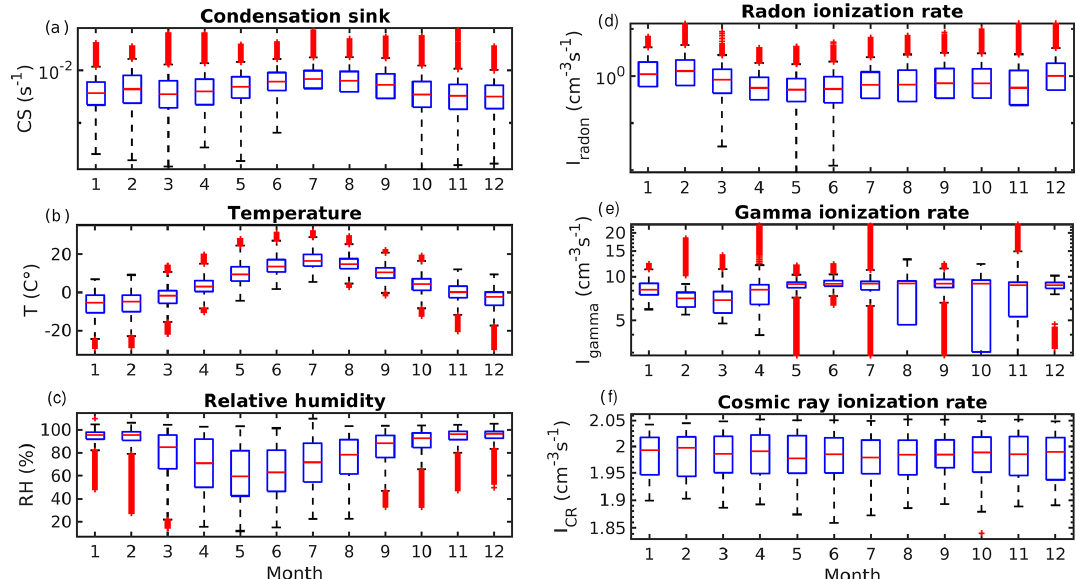
Figure 7. The annual variation of CS, T , RH, I R , I g , and I CR . The red line is the median concentration, and the blue box contains 50% (25th to 75th percentile) of all data points. The whiskers mark the location of the 95th and 5th percentile data points. The numbers on the x axis are month numbers. The red crosses are